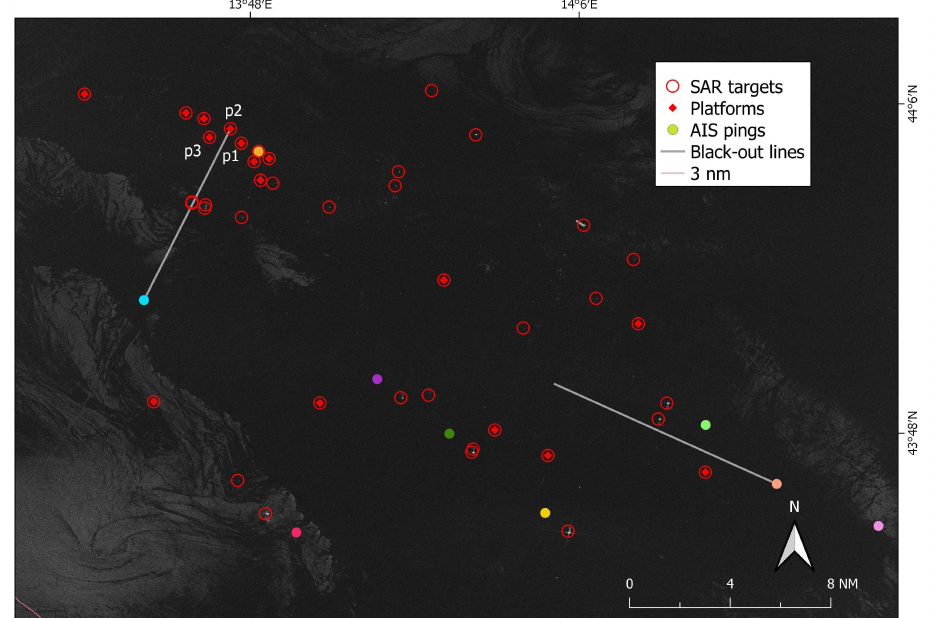
Figure 8. Close-upviewoftheSentinel-1imagetakenasexample(VVchannel), overlaying41SUMO/SAR detections, 9 AIS reported positions, 3 AIS blackouts and 6 offshore platforms. The starting vertex of the blackout entering the managed area of platform p2 is at the same time (for the given MMSI) the ping nearest to the SAR epoch (cyan AIS position).